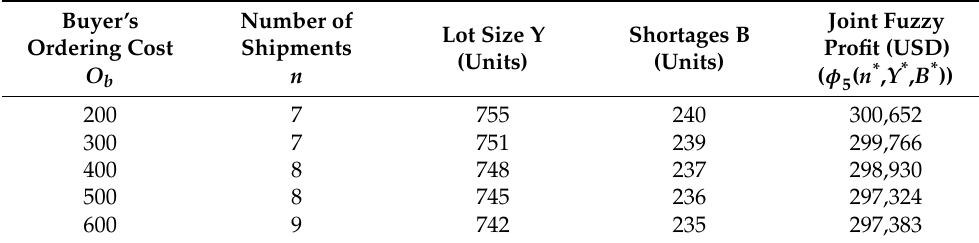
Table 18. Impact of the buyer’s ordering cost on the decision variables and joint fuzzy profit.